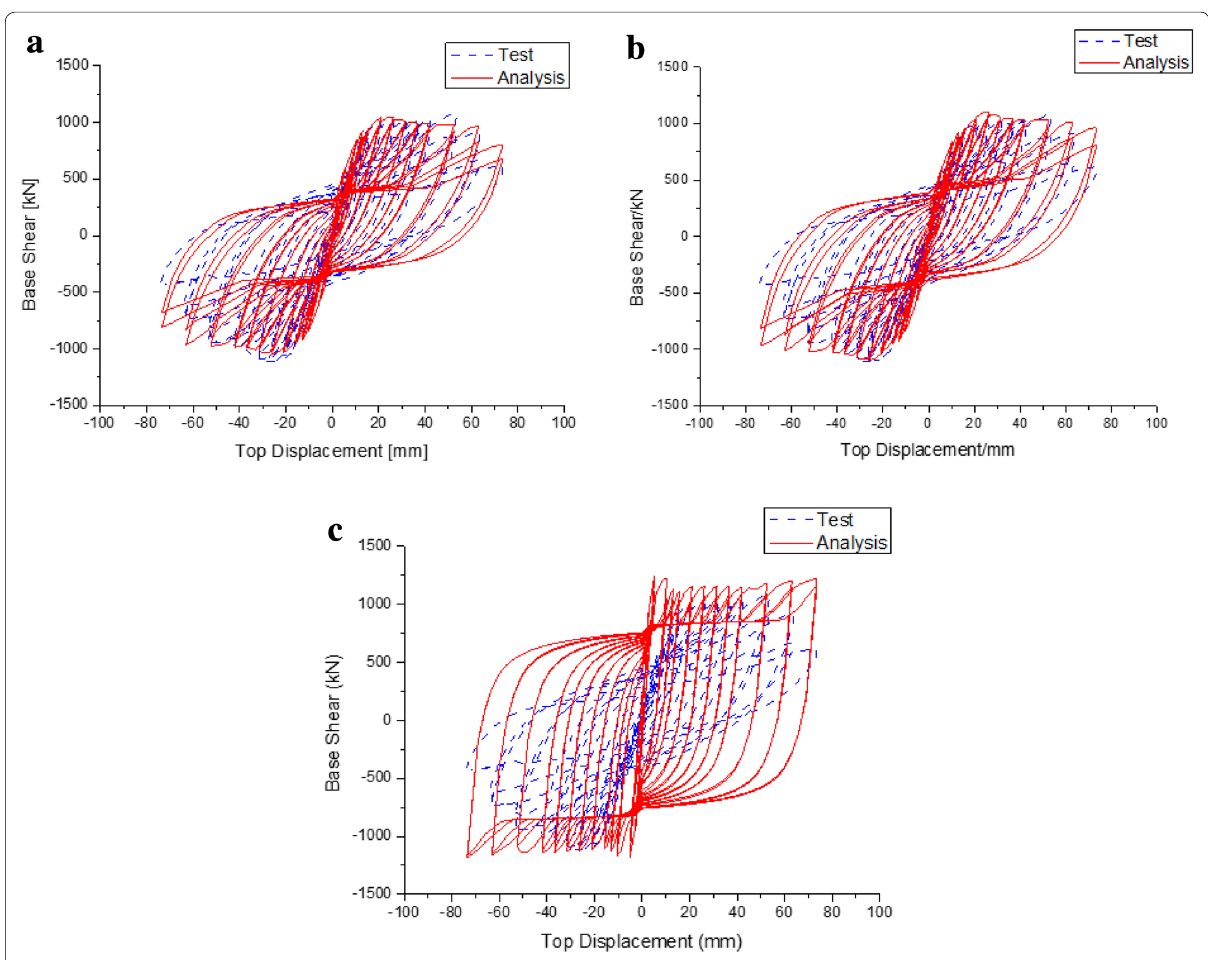
Fig. 8 Comparison of the hysteretic curves of SD-2.0 using a Mander confined concrete model and proposed shear model. b Legeron confined concrete model and proposed shear model, c Mander confined concrete